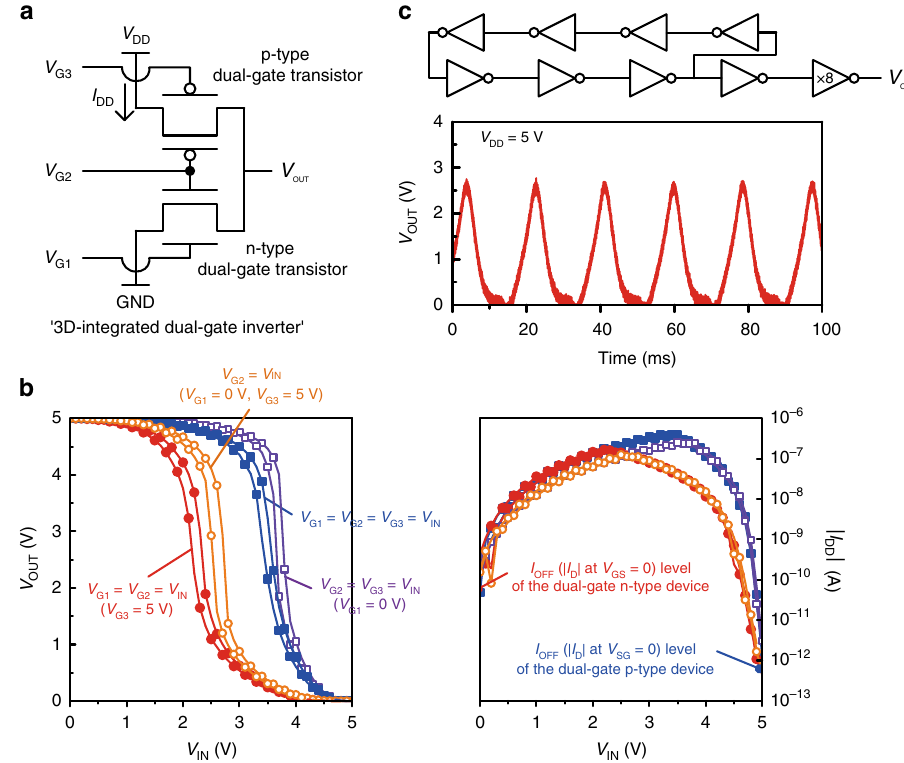
Fig. 5 Stacked 2-T dual-gate devices. a Schematic circuit of the 3D-integrated dual-gate inverter ( V G1 , V G2 , V G3 : gate inputs, I DD : static current from the source). b Voltage transfer characteristics (left) and static currents (right) of the inverter operation according to the combinations of electrical gate connections. c Schematic circuit of the ring oscillator which is composed of seven 3D-integrated dual-gate inverters and its oscillation operation. The buffer output stage consists of serially connected two inverters, where the transistor W of the last inverter is designed to be eight times larger than that of the